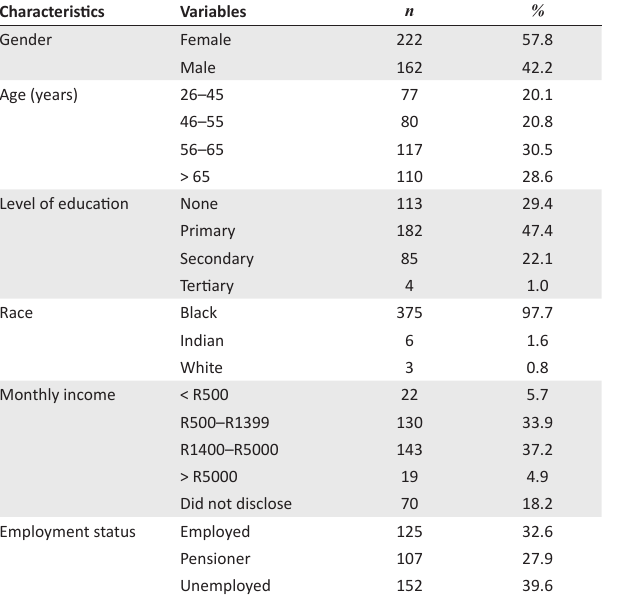
TABLE 1: Sociodemographic characteristics of patients with glaucoma in the uThungulu Health District, 2016–2017. Characteristics